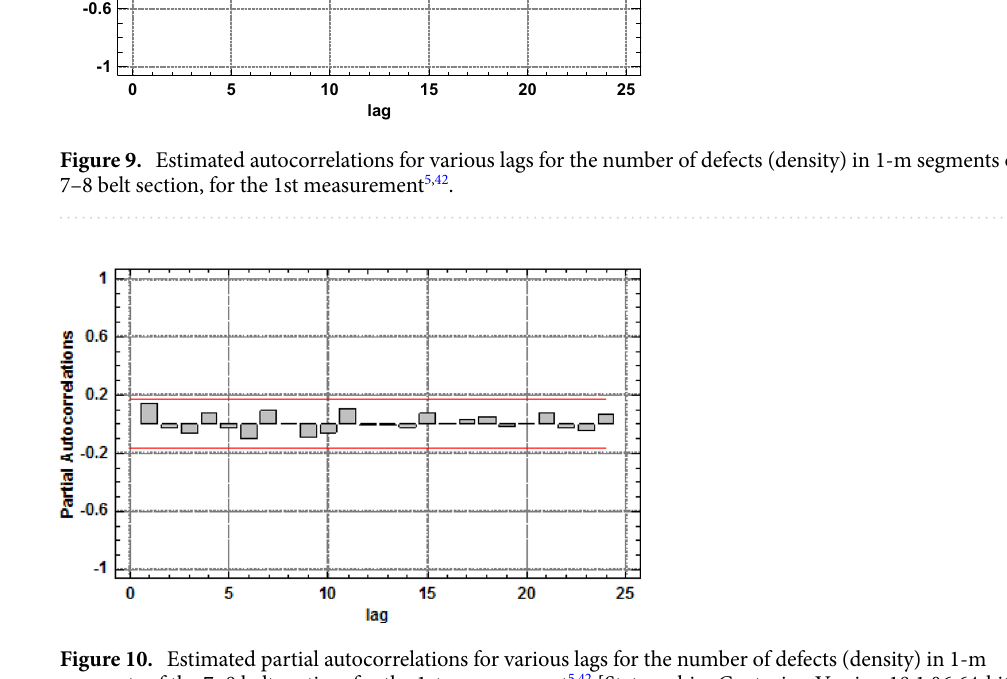
Figure 10. Estimated partial autocorrelations for various lags for the number of defects (density) in 1-m segments of the 7–8 belt section, for the 1st measurement 5,42 [Statgraphics Centurion Version 18.1.06 64-bit version (academic license of Wrocław University of Science and Technology), https:// www. statg raphi cs. com/].